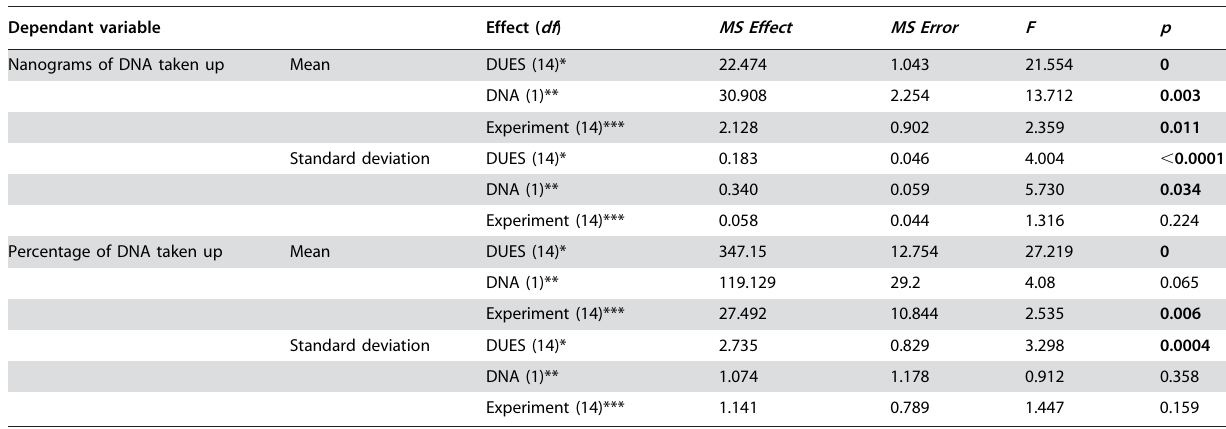
Table 5. Effect of the DNA concentration in the medium, the strength of the DUES, and the experiment on DNA uptake efficiency